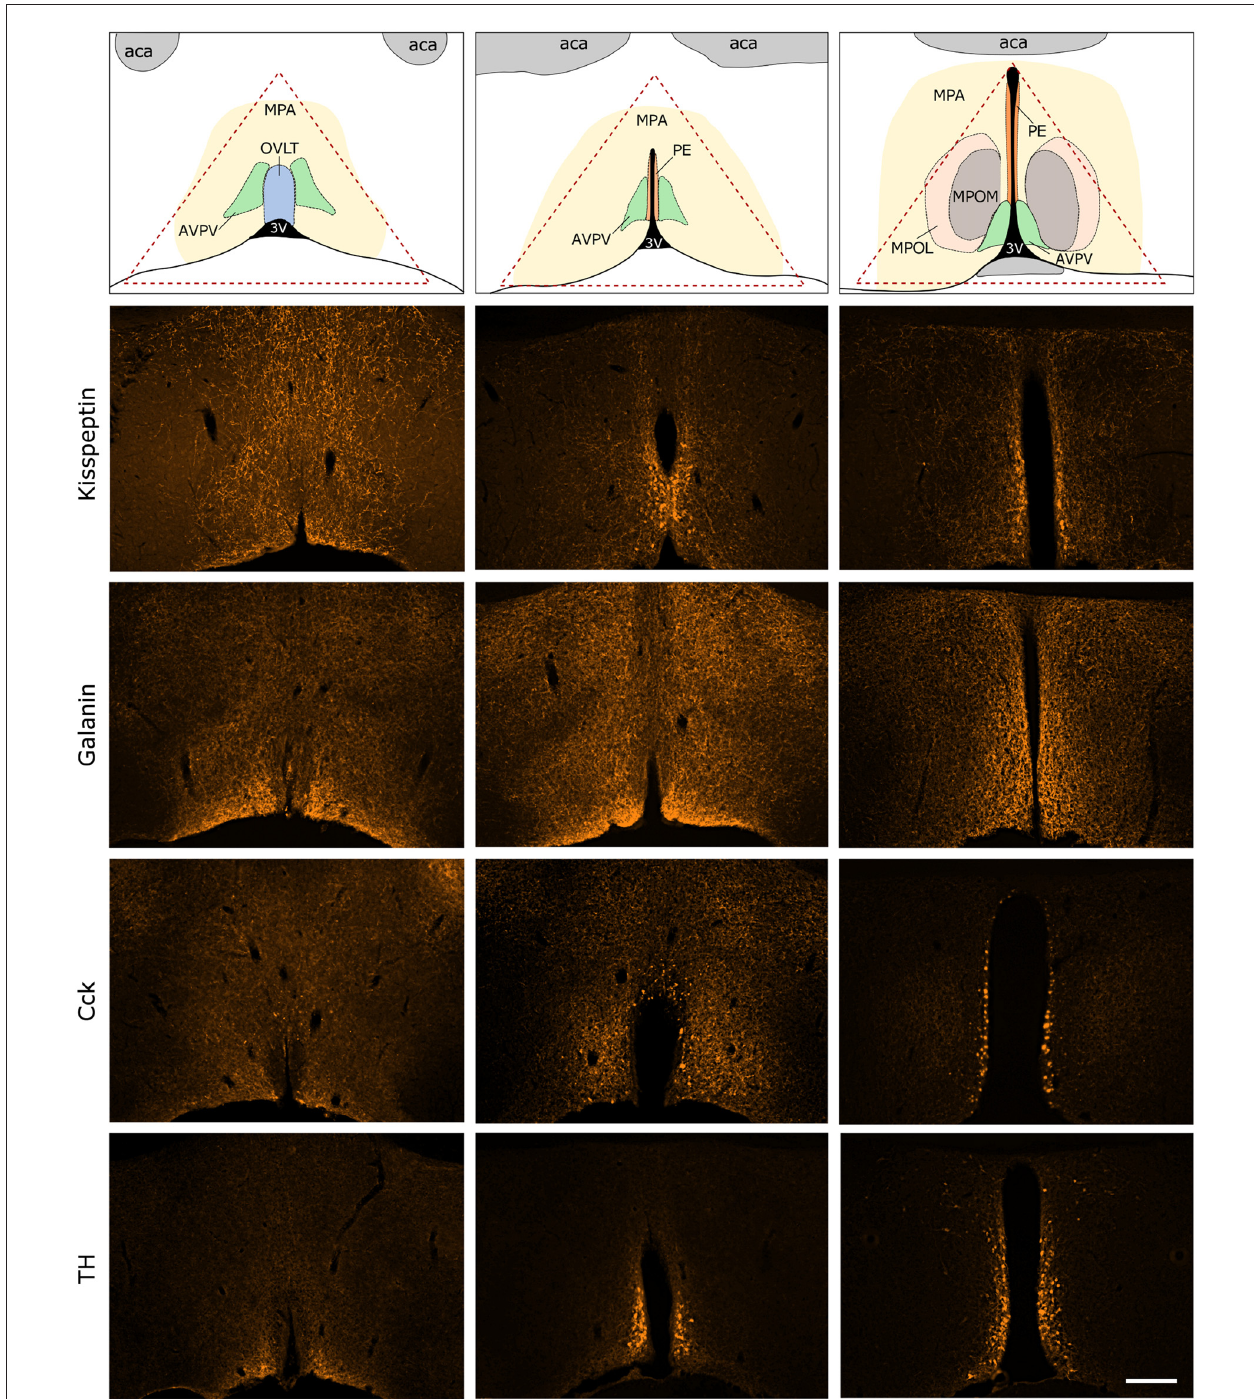
FIGURE 3 | Immunocytochemical localization of kisspeptin (KP), galanin (GAL), cholecystokinin (CCK) and tyrosine-hydroxylase (TH) in the antero-ventral periventricular/MPA of the proestrous mouse. The uppermost row illustrates the MPA and its subdivisions in three representative rostro-caudal planes (from left to right). Red triangle indicates the border lines of tissue area sampled for the real-time PCR study. Immunofluorescent detection of KP, galanin, CCK and TH is provided in the three, representative frontal planes. KP, CCK and TH appear in cell bodies within the AVPV and the periventricular nucleus (PE) in addition to neuronal processes. Galanin-immunoreactivity is not detectable at the level of perikarya in proestrous mouse, despite its intense occurrence in axons. aca, anterior commissure; AVPV, antero-ventral periventricular nucleus; MPOM, medial division of the medial preoptic nucleus; MPOL, lateral division of the medial preoptic nucleus; OVLT, vascular organ of lamina terminalis; 3V, 3rd ventricle. Scale bar: 200 µ m.